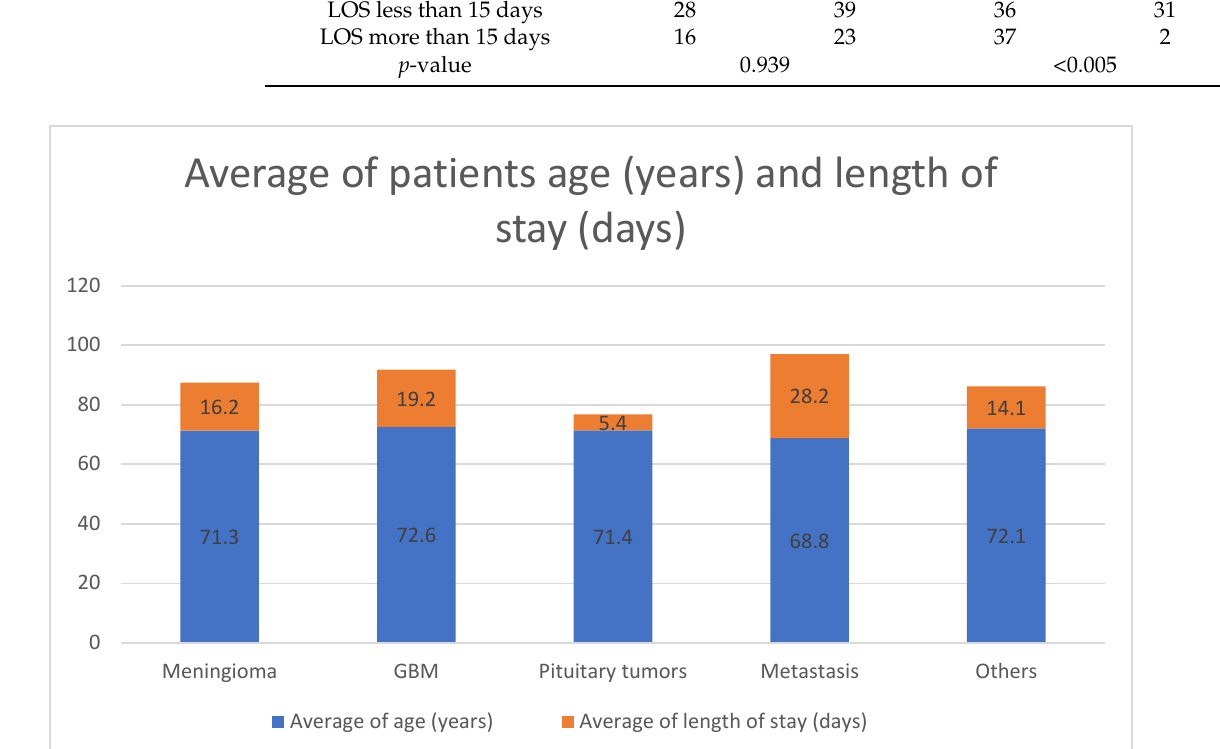
Figure 1. Average of patients’ age (years) and length of stay (days) in different types of tumors. GBM: glioblastoma multiform; Others: hemangioma, lymphoma, schwannoma.